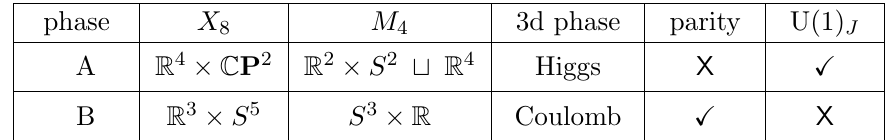
Table 1 . Two geometric phases of Spin(7) holonomy manifolds X 8 correspond to Higgs and Coulomb phases of 3d N = 1 e(cid:11)ective (cid:12)eld